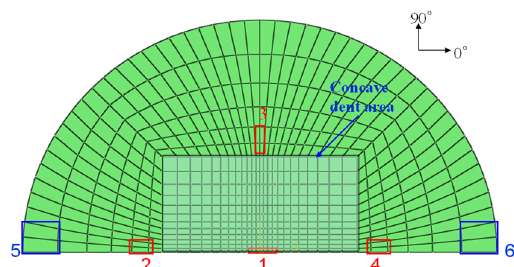
Figure 13. Detection of stress at different locations.